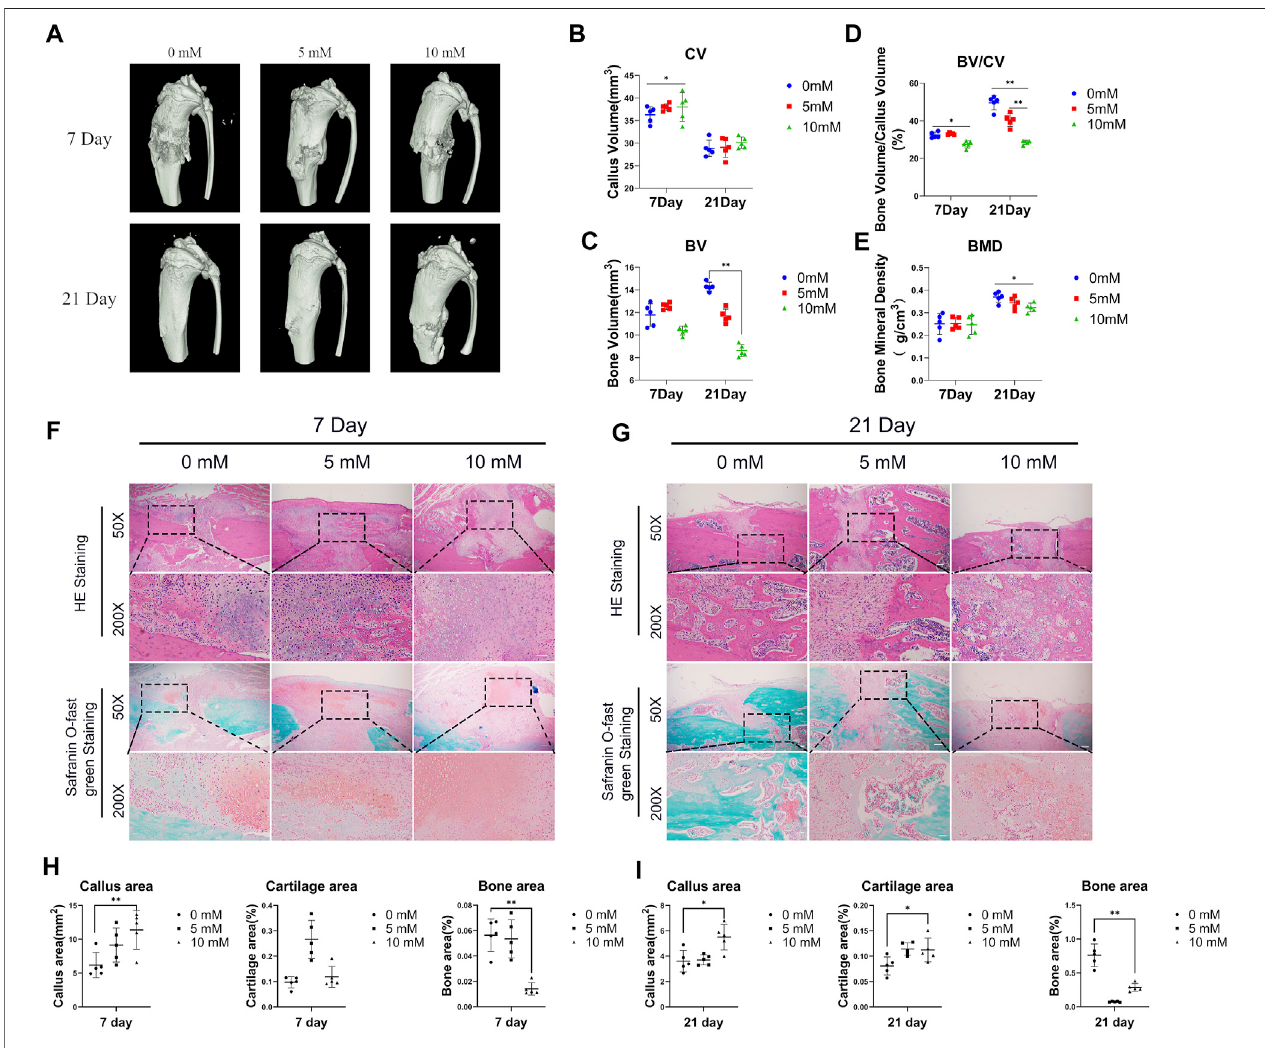
FIGURE 1 | Excessive fl uoride intake impaired fracture healing. (A) The tibia was subjected to micro-CT analysis. Representative micro-CT 3D images are shown. (B,C,D,E) Quanti fi cation results of the relative values of BV, CV, BV/CV, and BMD were analyzed. These data are shown as mean ± SD repeated in triplicate, * p < 0.05; ** p < 0.01. (F,G) H&EstainingandsafraninO-fastgreenstainingwereperformedtodeterminethecallusarea,cartilagearea,andbonearea(magni fi cation×50,scalebar = 400 μ m; × 200, scale bar = 100 μ m). Representative images are shown. (H,I) The areas of callus, cartilage, and bone were quanti fi ed using ImageJ. * p <